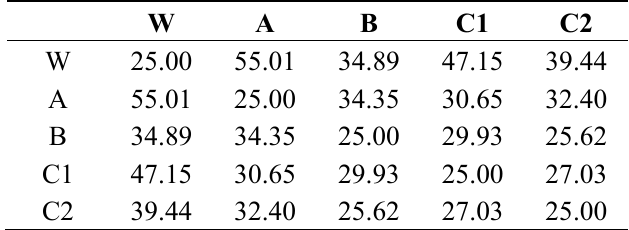
used in these ij